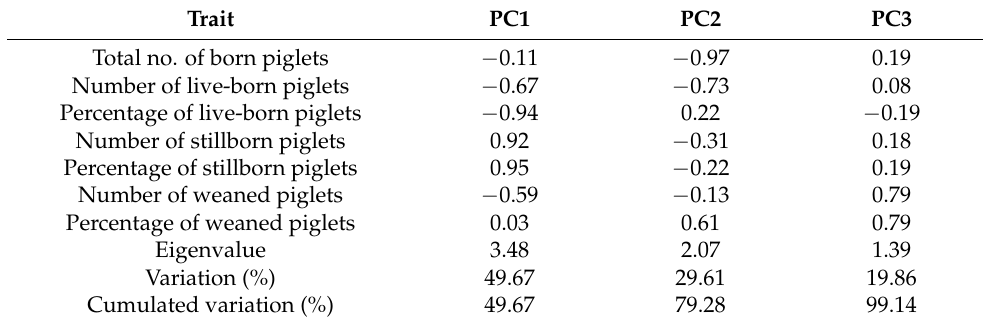
Table 8. PCA for marker SW1808 in Polish Large White sows: Eigenvalues, variance explained, cumulative variance explained, and correlation coefficients with the original traits of the first three principal components